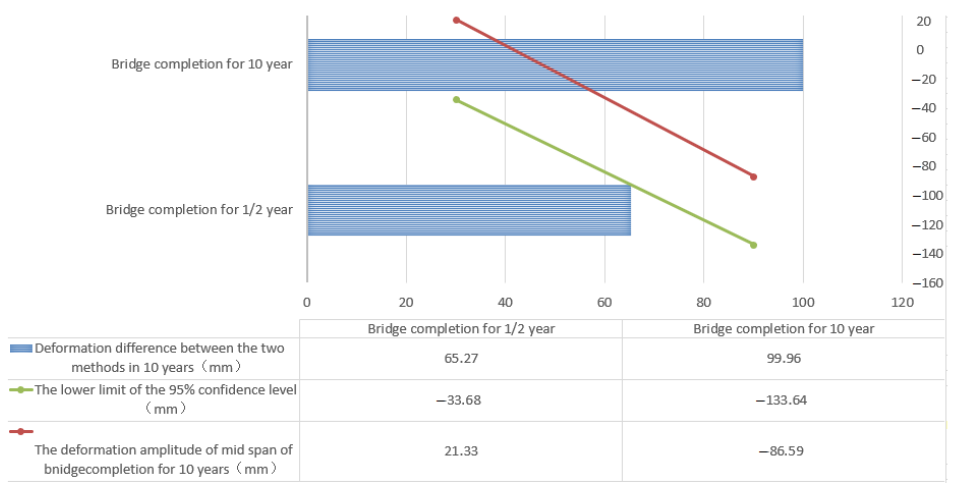
Figure 10. Comparison of 10-year deformation amplitude (unit: mm).